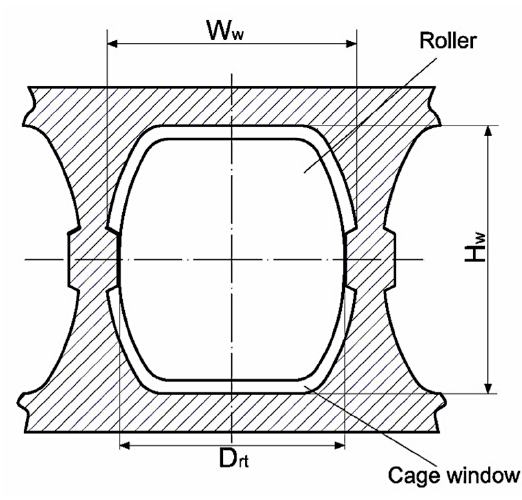
Figure 3. Shape and main dimensions of the window existing in the bearing cage.